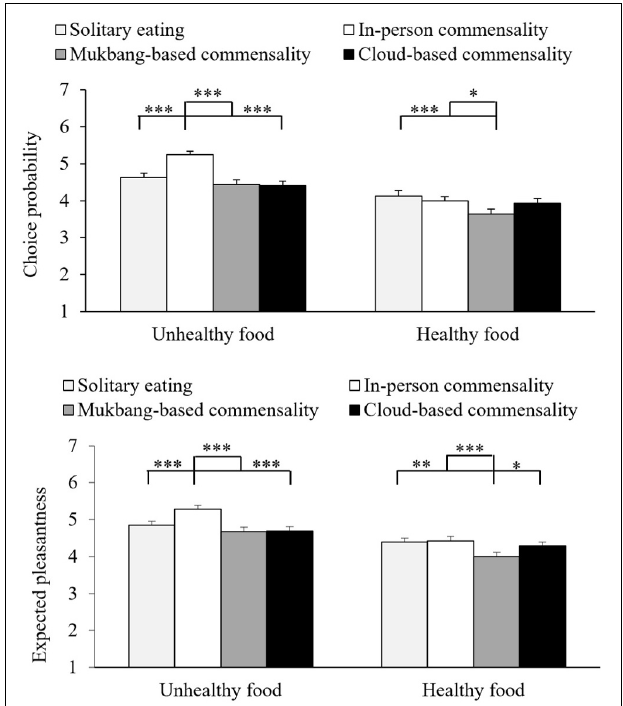
Main effect of Scenario